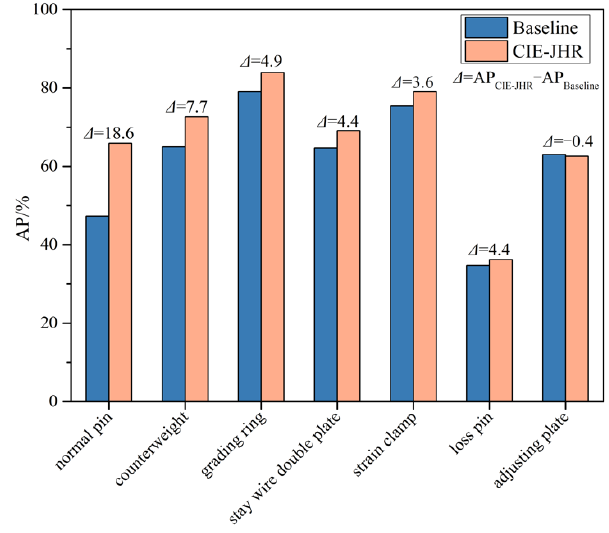
Figure 10. Comparison of the detected objects by CIE-JHR and dynamic ATSS methods. Table 5. Comparison of the detection